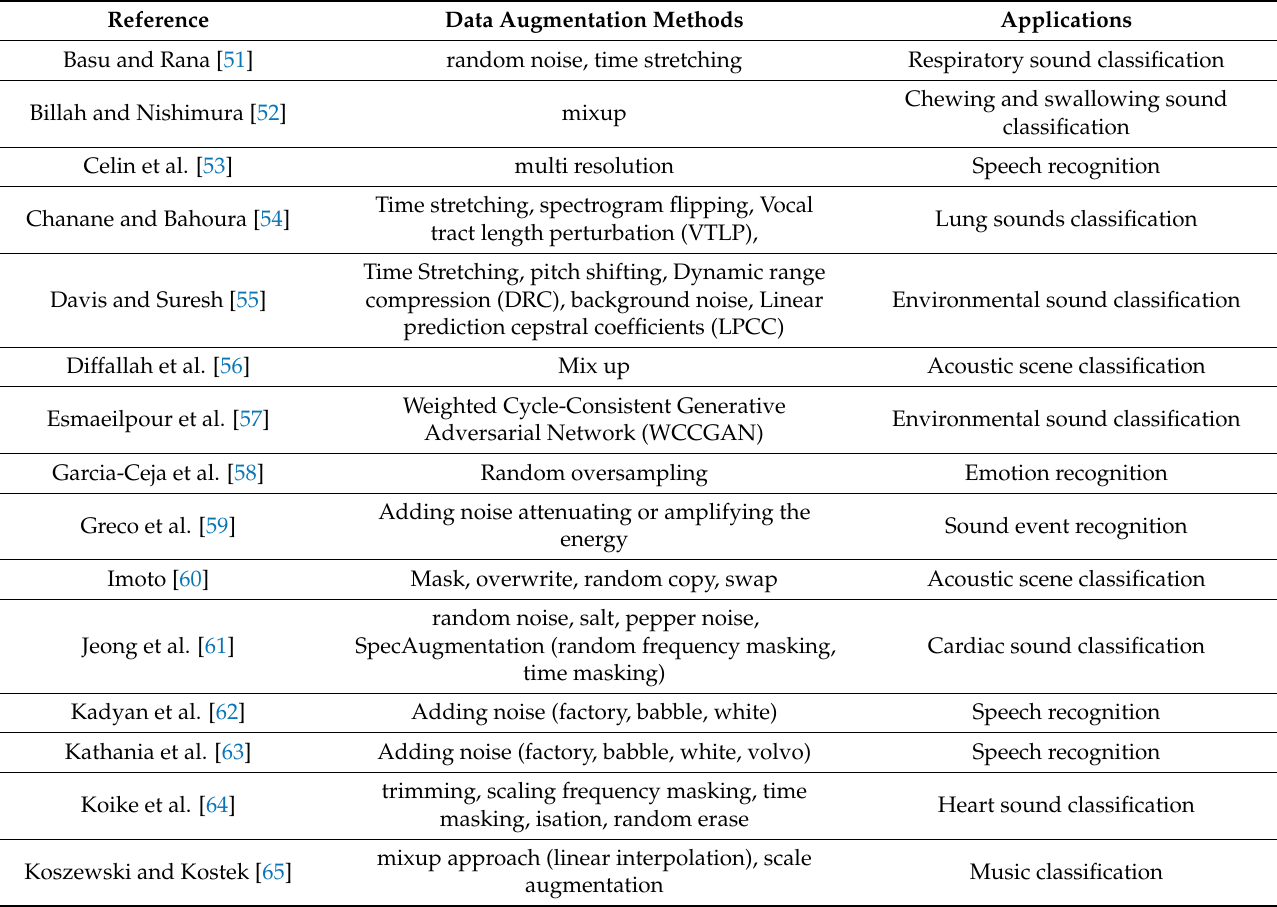
Table 4. Summary of data augmentation